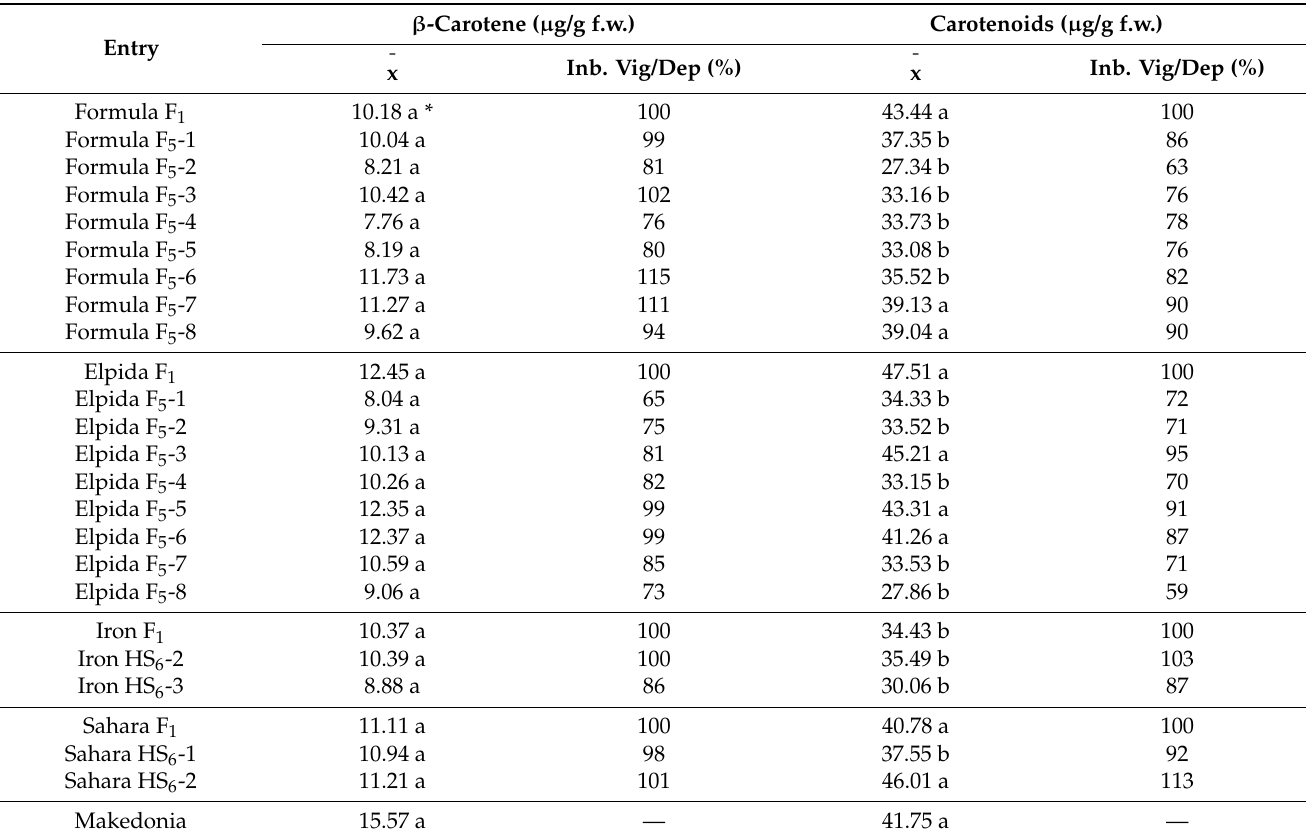
Table 2. Average fruit β -carotene ( µ g/g f.w.), total carotenoids ( µ g/g f.w.), and inbred vigor/depression (% of corresponding hybrid), for tomato hybrids and recombinant inbred lines.